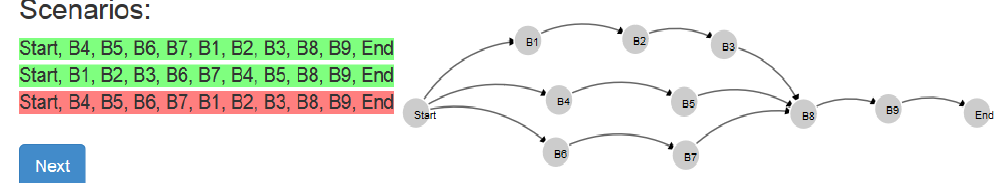
Figure 9. The repeated scenario does not lead to changes in the model.